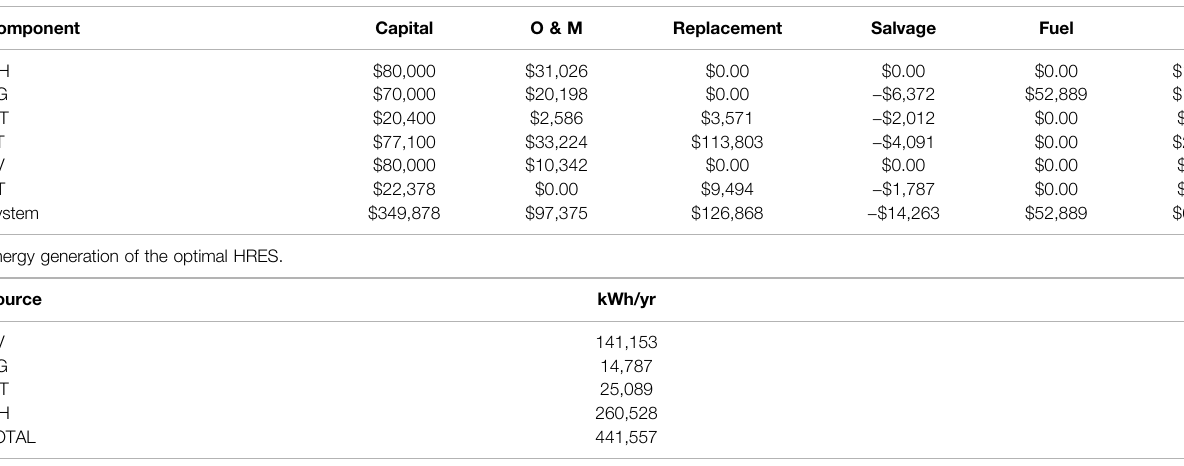
TABLE 10 | Detail cost analysis of HRES.